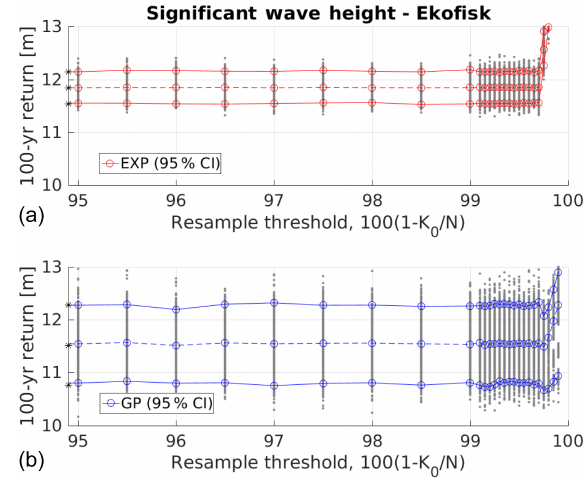
Figure 8. Bootstrapping the upper percentiles P = P 90 ,P 95 ,P 97 ,P 99 and P 99 . 9 . The ratio r = K 0 /k is shown as a function of sample size N . Here, the minimum number of entries required is k = ( 1 − P)N/ 100. The probability of con- tamination is kept fixed at p c = 0 . 01. At sample sizes larger than approximately 10 4 , a ratio r = 2 is sufficient for all percentiles investigated. The curve representing the 99th percentile is marked in red (with diamonds) and corresponds to the red curve in Fig. 7.